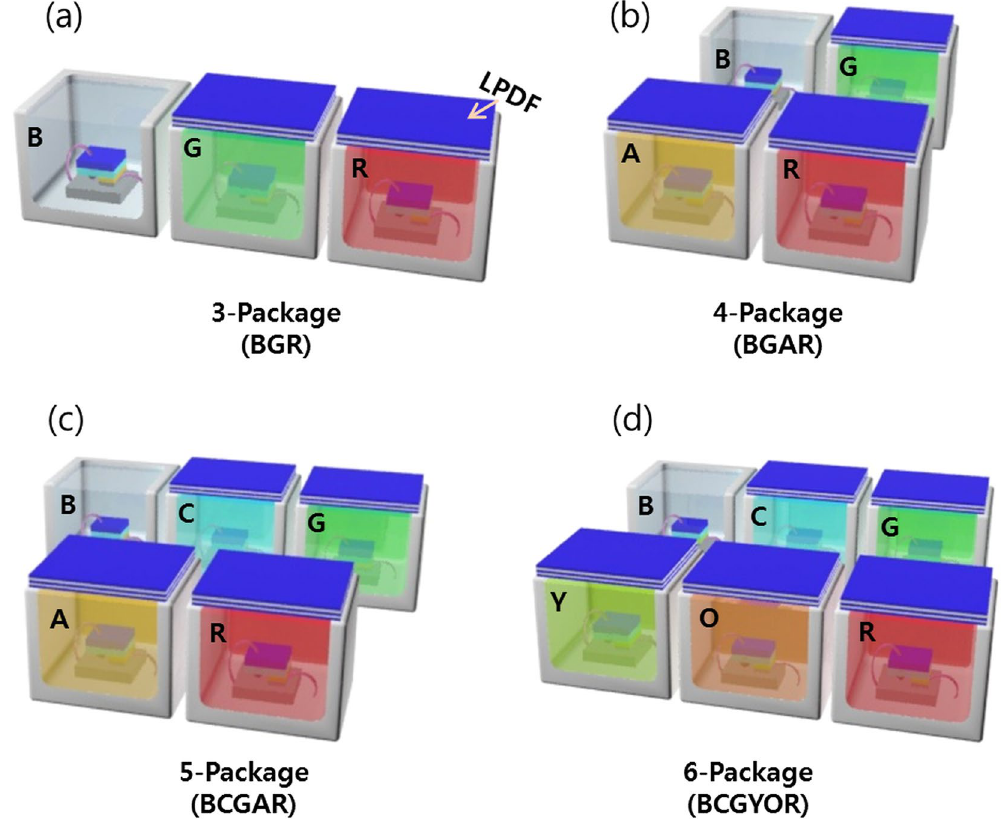
Figure 2. Schematic diagram of four types of multi-package white LEDs incorporating colored